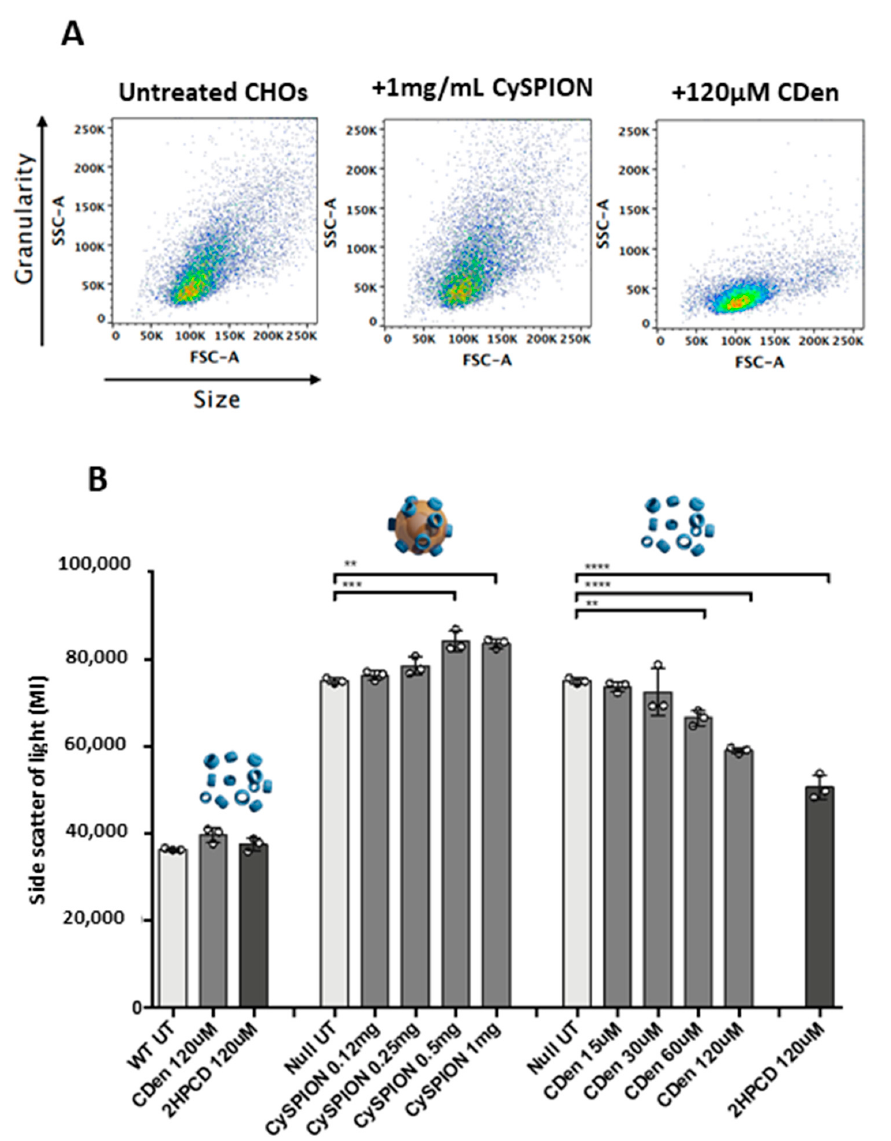
Figure 3. ( A ) Npc1-deficient CHO Cell profile on flow cytometer. Side scatter (SSC-A) vs. forward scatter (FSC-A). ( B ) Side scatter of WT and Npc1-deficient CHO cells treated with the indicated doses of CySPION, CDen, or 2HPCD for 72 h. A 1 mg CySPION dose is equivalent to 120 µM CDen. Data are mean ± SD, N = 3 replicates per sample. Statistical analysis, one-way ANOVA, **** p < 0.0001, *** p < 0.001, ** p < 0.01. Data are representative of two independent experiments. It should be noted that Npc1-de fi cient CHO cells are more granular (increased side sca tt er) than WT cells (Figure 3B). This is due to the build-up of cholesterol-rich, multi- concentric, lamella-like structures in the perinuclear vesicles of these cells [41]. Treatment with soluble cyclodextrin decreases granularity, presumably by reducing the size/number of these structures. CySPION treatment increases cell granularity due to the accumulation of nanoparticles inside the cell and/or on its surface. Due to both CDen and CySPION treatment reducing the LysoTracker signal, we can postulate that the lamella-like struc- tures are also reduced in CySPION-treated cells, but that the presence of the nanoparticles masks this e ff ect.